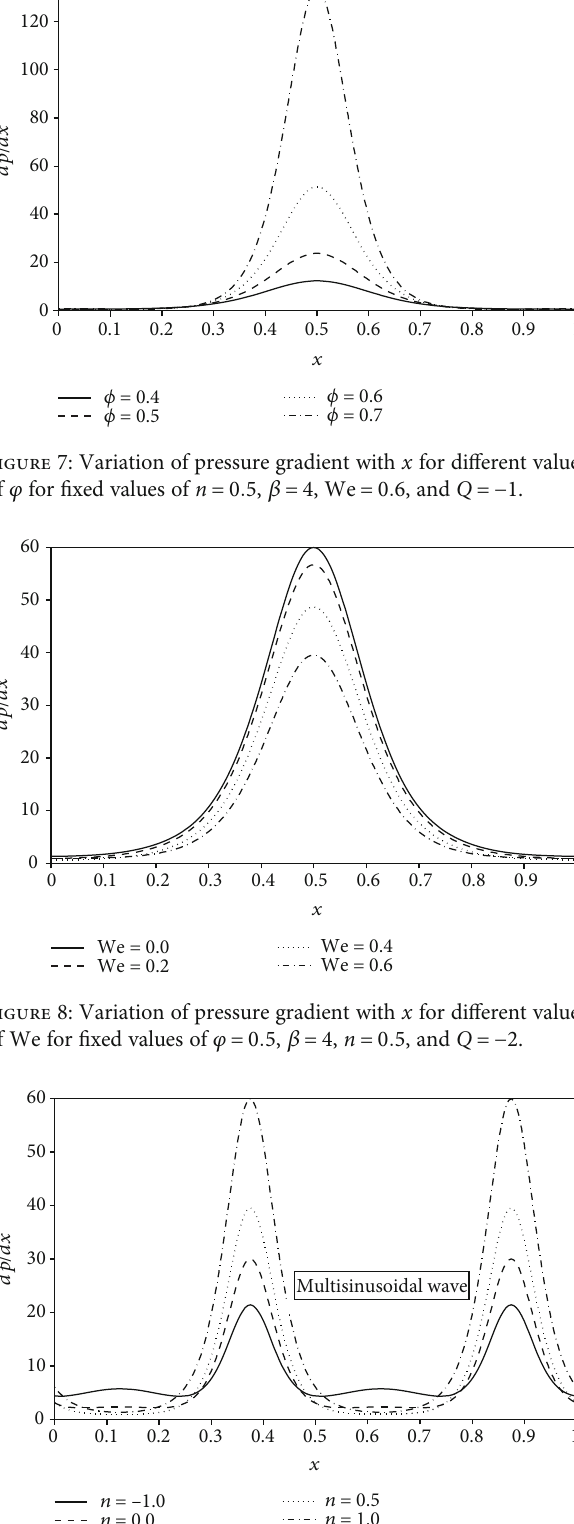
Figure 6: Variation of pressure gradient with x for di ff erent values of n for fi xed values of φ = 0 : 5 , β = 4 , We = 0 : 6 , and Q = − 2 .